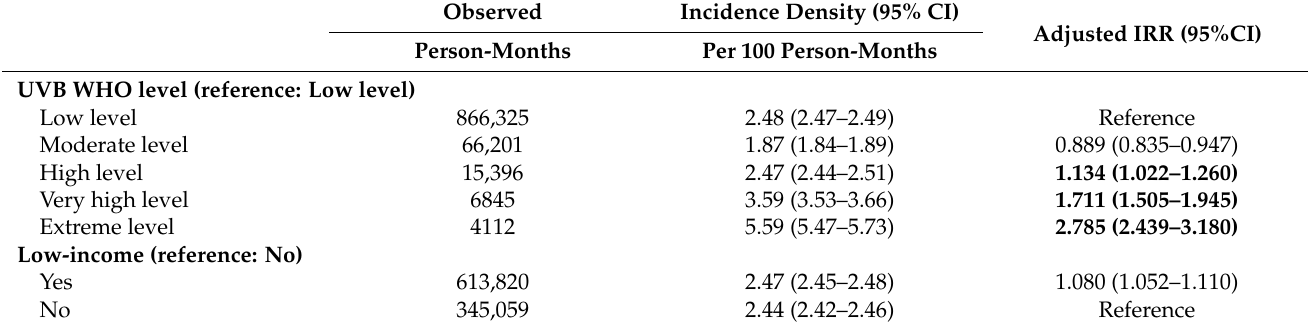
Table 3. Poisson regression analysis of Ultraviolet radiation b (UVB) and